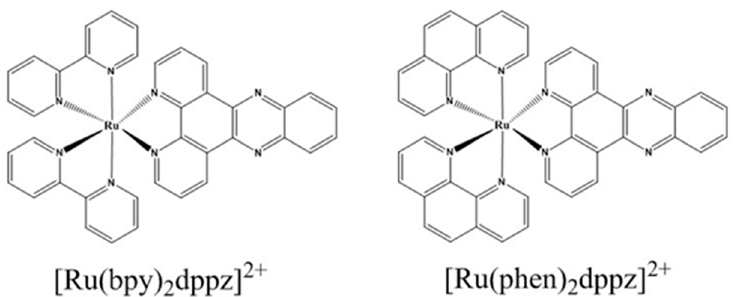
Figure 2. Chemical structures of intercalated ruthenium compounds. Reproduced with permission from the authors of [15]. Copyright © 1992, American Chemical Society.